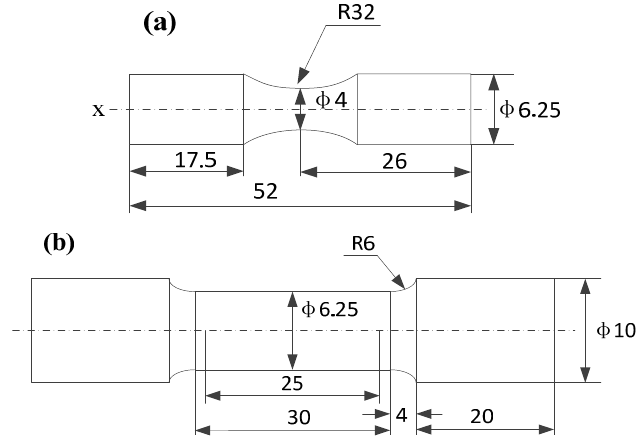
Figure 3. The schematic diagrams for tensile and fatigue samples: ( a ) fatigue sample; ( b ) tensile sample.